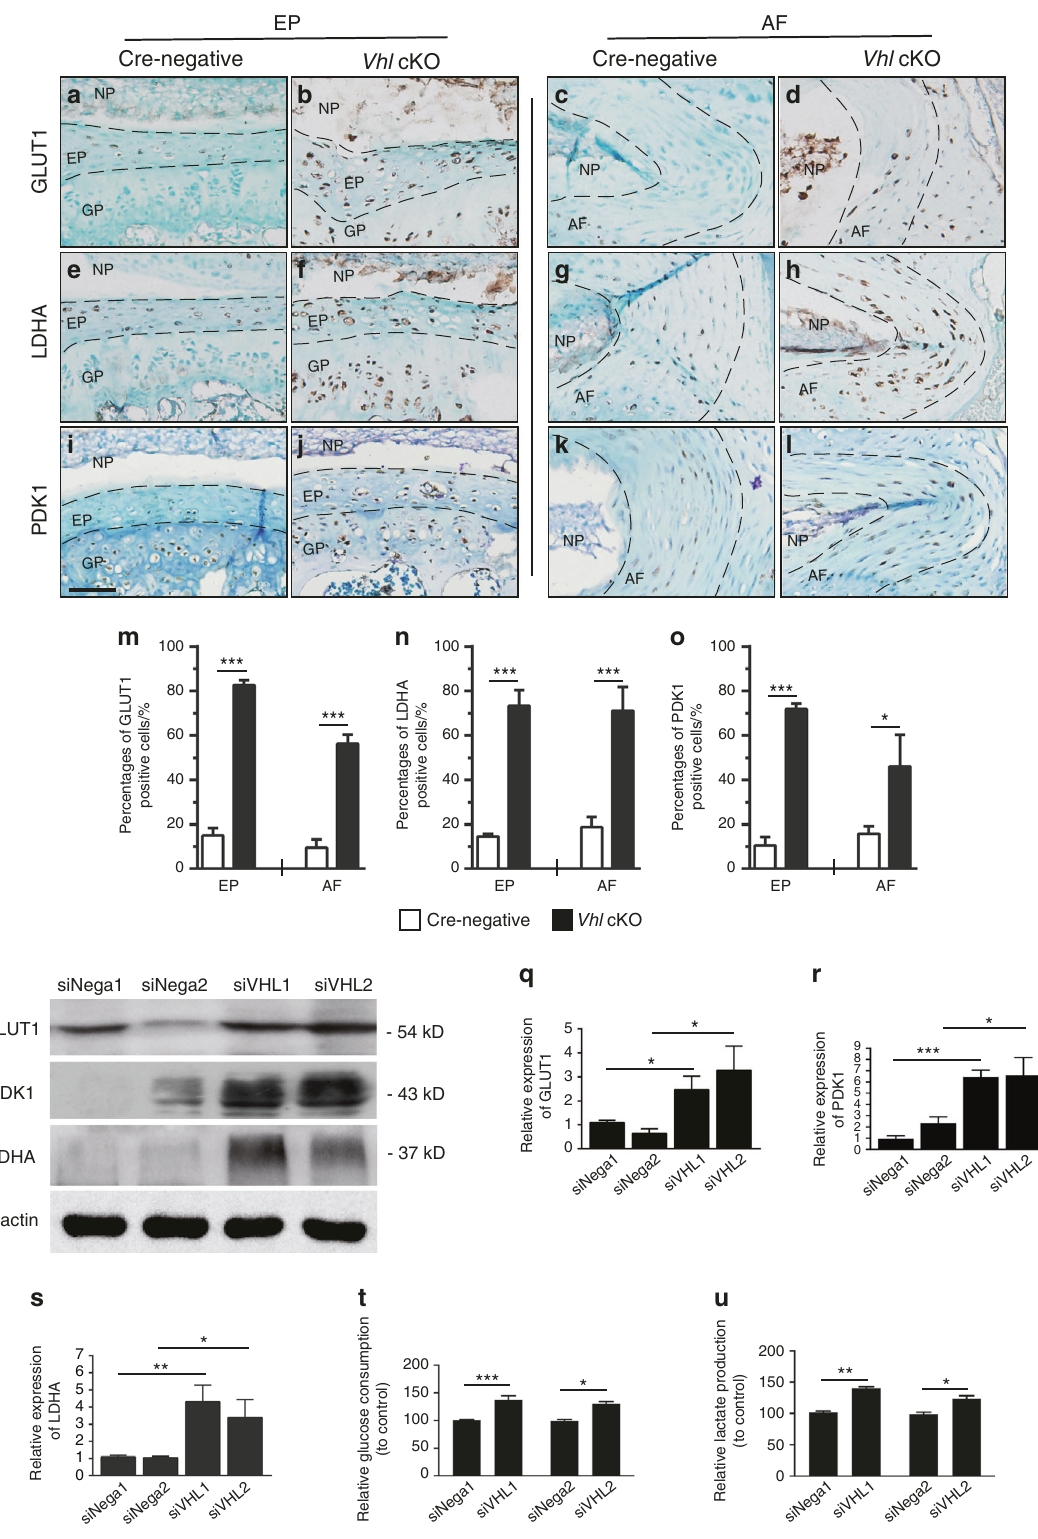
Fig. 5 Aberrant HIF1 α signaling enhances glycolytic metabolism. a – l Immunohistochemical detection of GLUT1, LDHA, and PDK1 expression in lumbar discs of WT and Vhl cKO mice ( n = 3 – 5 per group). m – o Percentages of GLUT1-, LDHA- and PDK1-immunoreacted positive cells. m , GLUT1-; n , LDHA-; and o , PDK1-positive cells were quanti fi ed. p Western blotting analysis of GLUT1, PDK1, and LDHA expression in iAF cells in the siRNA-Vhl group, where the siNega group was used as a control. q – s The signal intensities were quanti fi ed ( n = 3 per group). t – u The glucose consumption and lactate production of iAF cells transfected with siRNA-Vhl were determined. Scale bar: 50 µm ( a – l ). Data are expressed as the percent expression relative to controls. Values represent the mean (symbols) ± SD (error bars). *P < 0.05 ; **P < 0.01 ; ***P < 0.001